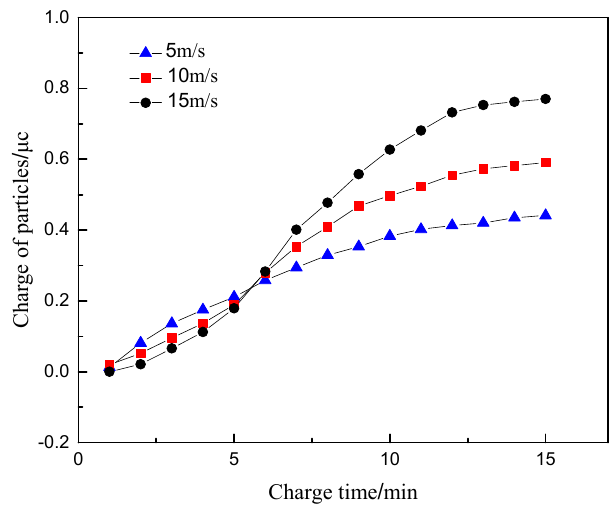
Figure 6. The relationship between the charge amount of particles and time at di ff erent flow rates.